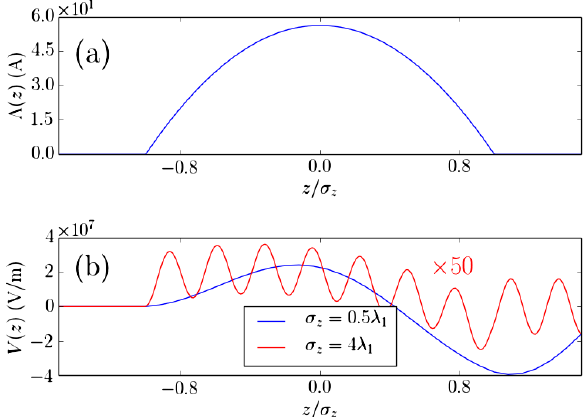
FIG. 3. Charge distributions (a) and corresponding wake potential (b) for two cases of ratio between the rms bunch length σ λ z and fundamental-mode wavelength 1 . The DLW structure parameters are identical to one used in Fig. 1. The head of the bunch corresponds to z ≤ 0 . The wake potential associated to the σ 0 . 5 λ z ¼ 1 case is scaled by a factor 50 for